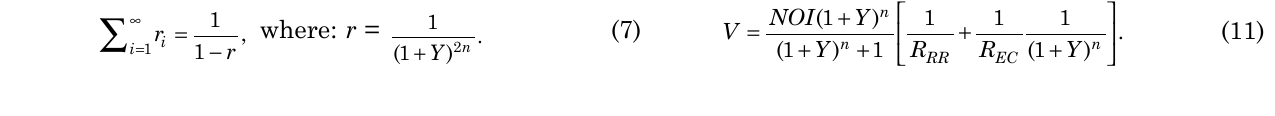
table 1. comparison between direct capitalization and cyclical capitalization (primum group) Direct capitalization formula cap rate noI = NOI V formula 1 R formula 2 a cyclical capitalization (primum group) formula cap rate